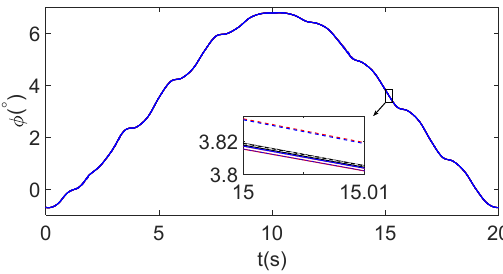
Figure 17. Yaw angle in the Monte Carlo simulation.